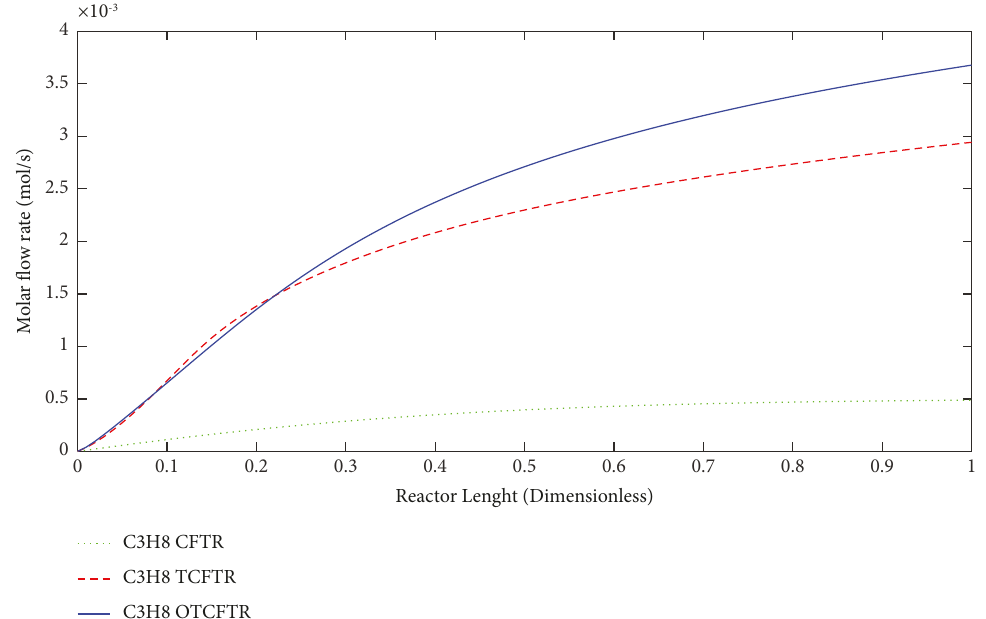
Figure 18: Comparison of the molar flow rate of propane in the exothermic part of the reactor for CFTR, TCFTR, and OTCFTR modes.